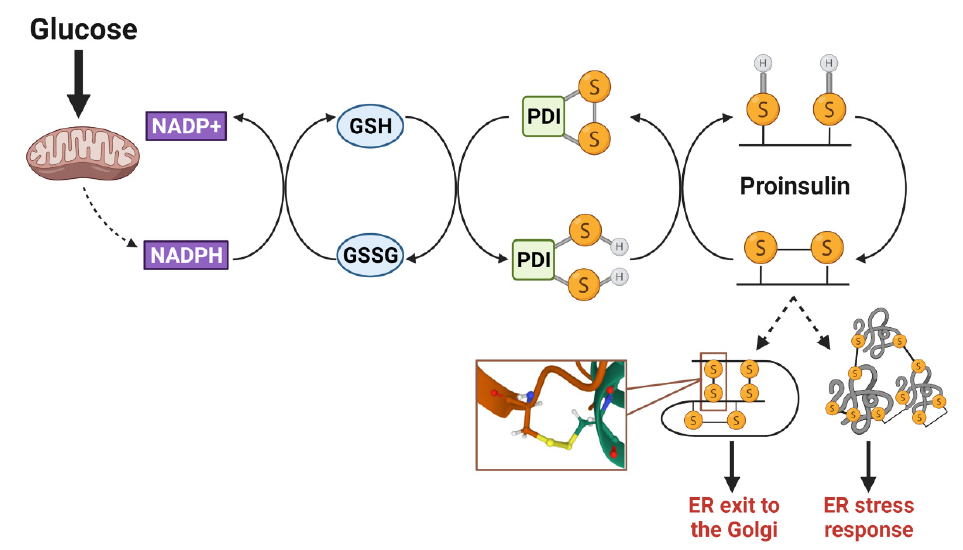
Figure 4. Proinsulin disulfide bond formation requires a redox shuttle. Isomerization of proinsulin disulfide bonds occurs through a metabolism-driven redox shuttle, involving NADPH/NADP+, glutathione (GSH/GSSG), and protein disulfide isomerases (PDIs). This process is necessary to correct mispaired cysteine residues that may lead to the formation of intermolecular disulfide bonds between proinsulin molecules. Upon proper folding and structural stabilization via the correct disulfide bonds, proinsulin exits from the ER and continues through the secretory pathway. SH denotes a free sulfhydryl in cysteine side chain; S-S denotes oxidized cystines in the disulfide bond. Images were created using Biorender.